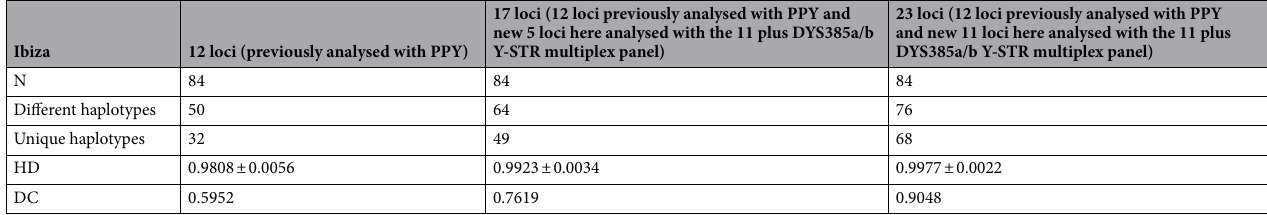
Table S6. Supplementary Table S7 provides the 23-loci haplotypes of the 84 individuals from this population. Forensic and population genetic parameters. At the single-locus level, DYS456, DYS458 and DYS576 loci were the most discriminative of the eleven incorporated Y-STRs included in the multiplex, generating the highest GD values (0.8181 for DYS576, 0.7533 for DYS458 and 0.7372 for DYS456) (Supplementary Table S6). The lowest GD value in this case was 0.4079 for DYS533. These results are maintained if DYS385a/b loci is included in the computation. At the haplotype level, the forensic and population genetics parameters of the Ibiza population based on